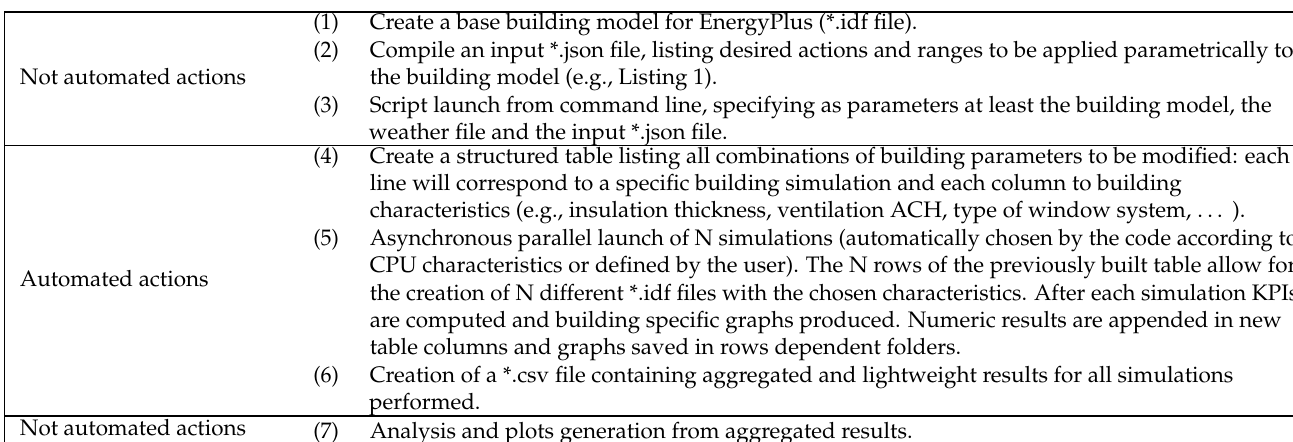
Figure 1. Draft of the PREDYCE architecture. Note: *.idf is a file with idf extension. Table 1. Workflow of a generic PREDYCE